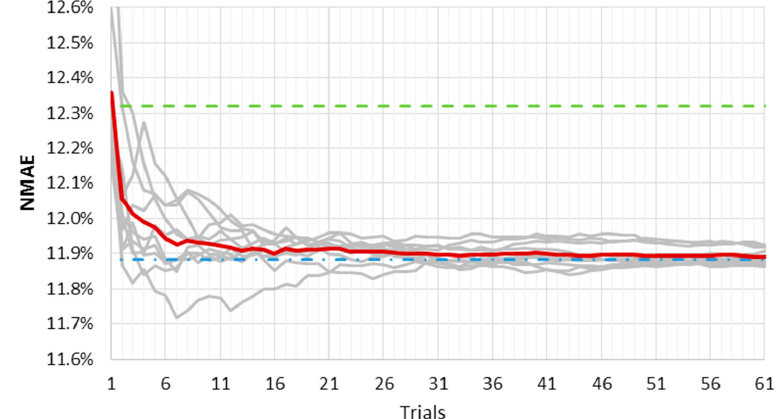
Figure 4. NMAE % of ten random ensemble (grey lines) as a function of the growing number of trials. The artificial neural network (ANN) has 120 neurons and a “Levenberg–Marquardt (LM) slow” training algorithm. The mean of the ten ensemble forecasts NMAE p is in red, the mean of one thousand forecasts is the dashed green line, and the ensemble NMAE % of one thousand forecasts is the dash-dotted blue line.